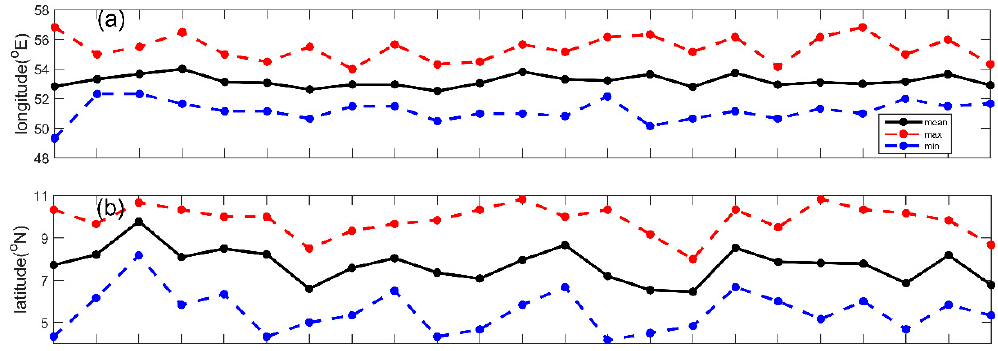
Figure 6. Time series of the positions of the GW center along the ( a ) longitude, ( b ) latitude direction from 1993 to 2015 (red line: maximum value, black line: average value, blue line: minimum value).